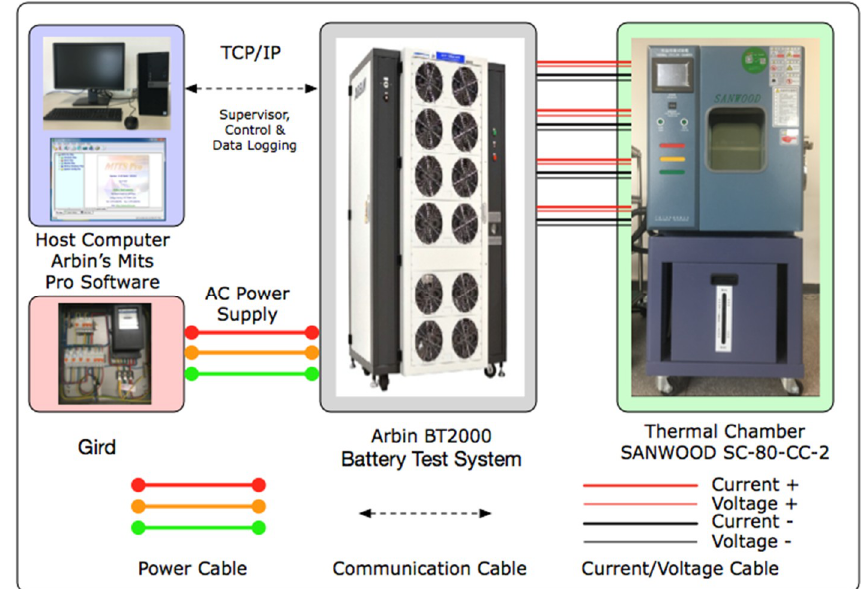
Figure 1. The schematic of the battery test bench.